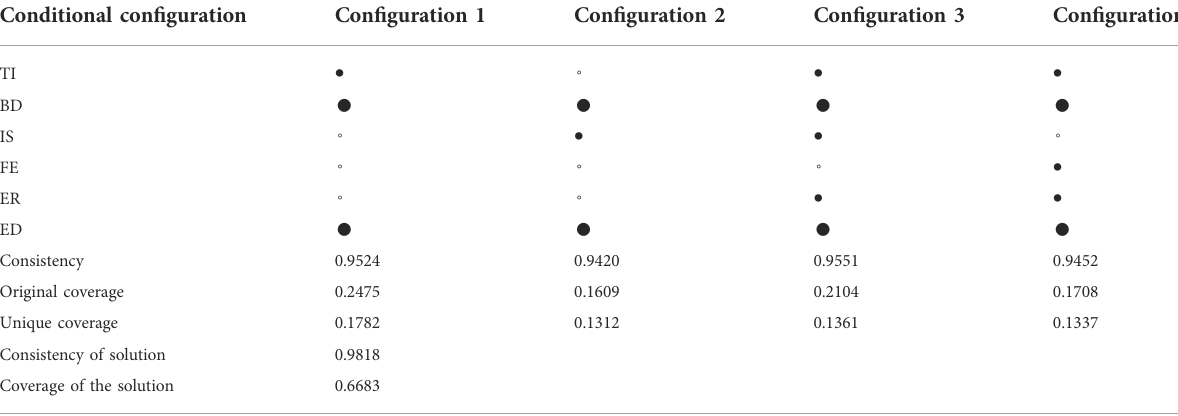
TABLE 6 Analysis of high-level circular economy performance con fi guration in central region.